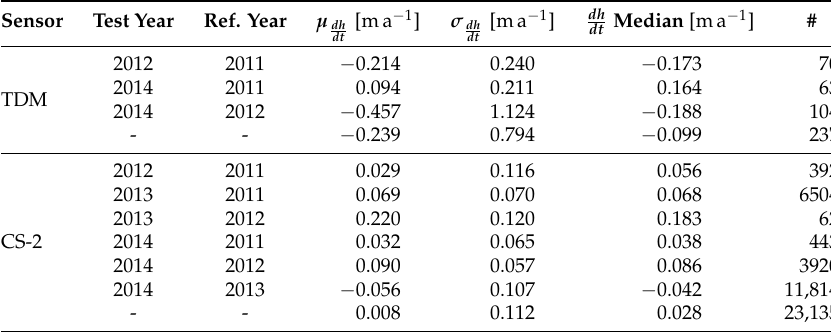
Table 2. dh comparison to IceBridge ATM (TDM/CS-2—ATM) for different time periods between 2011 dt and 2014. Differences have been extracted in patches of 500m for CS-2. The number of measurements # is the number of patches at which comparisons have been performed and relates to the sampling in the IceBridge ATM L4